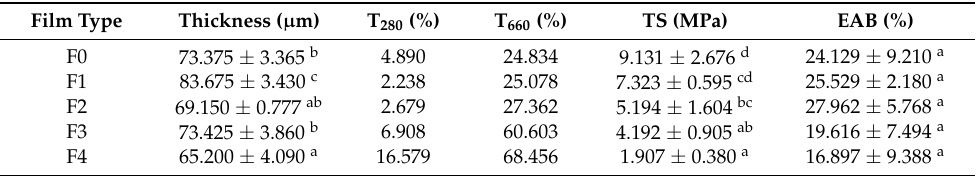
Table 1. Thickness, UV screening (T 280 ), transparency (T 660 ), tensile strength (TS), and elongation at breakage (EAB) of the bionanocomposite and control films.